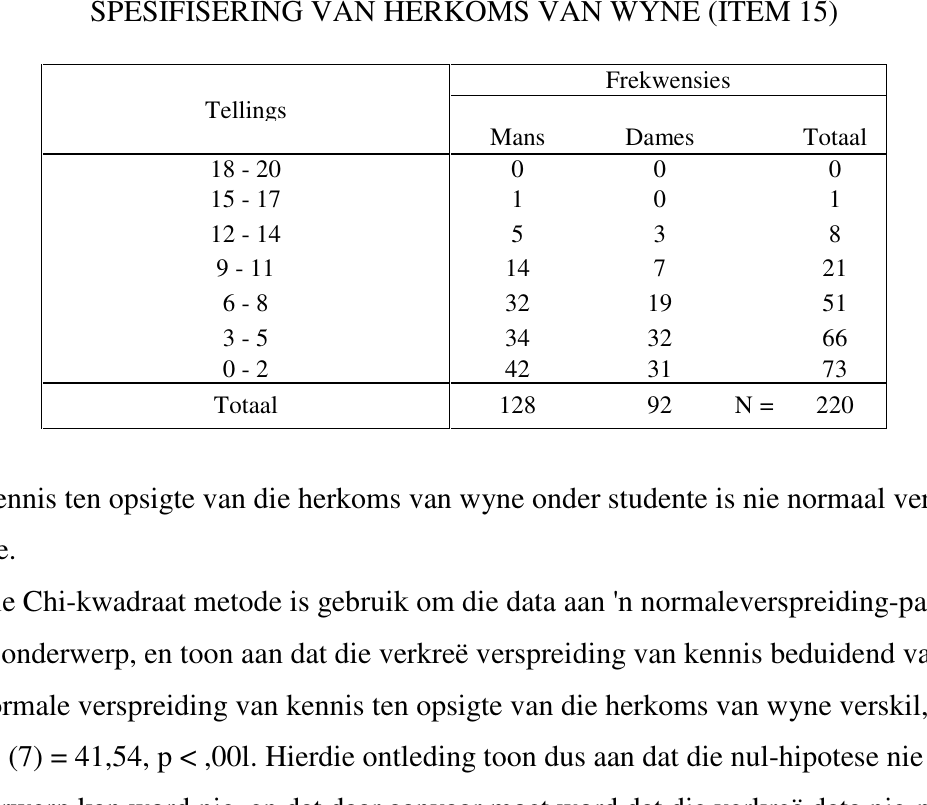
FREKWENSIETABEL VAN TELLINGS VAN PROEFPERSONE TEN OPSIGTE